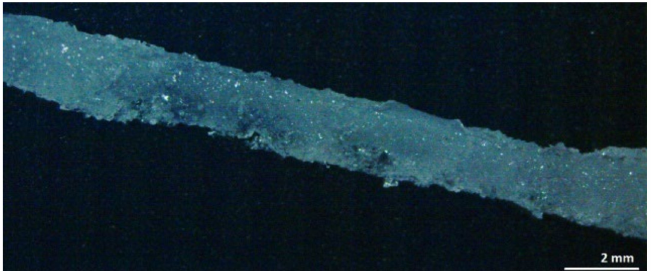
Figure 4. Optical microscopy image of sample design A representing Nusil Med 4850-PAMAA in swollen state (672 h). Hydrogel particle size fraction was 77 µ m, and hydrogel content was 30 wt% prior to